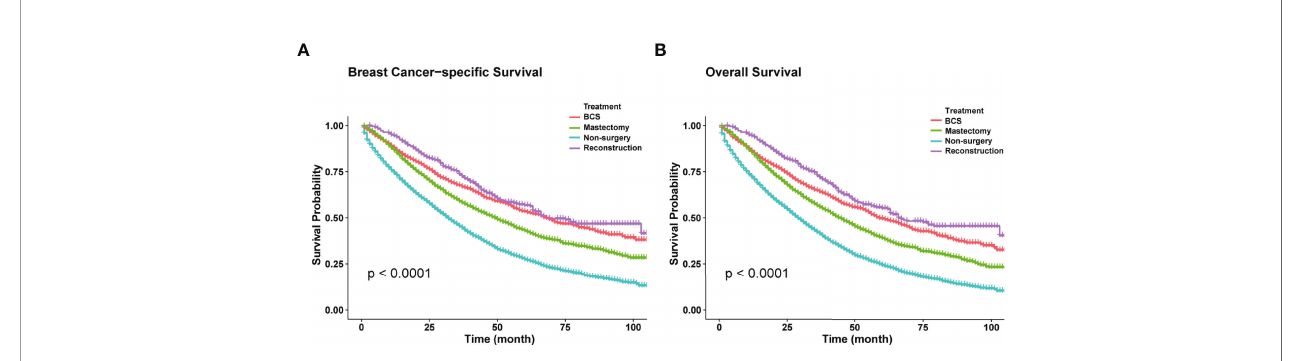
FIGURE 2 | (A) Kaplan-Meier curves of BCSS in different surgical methods. (B) Kaplan-Meier curves of OS in different surgical